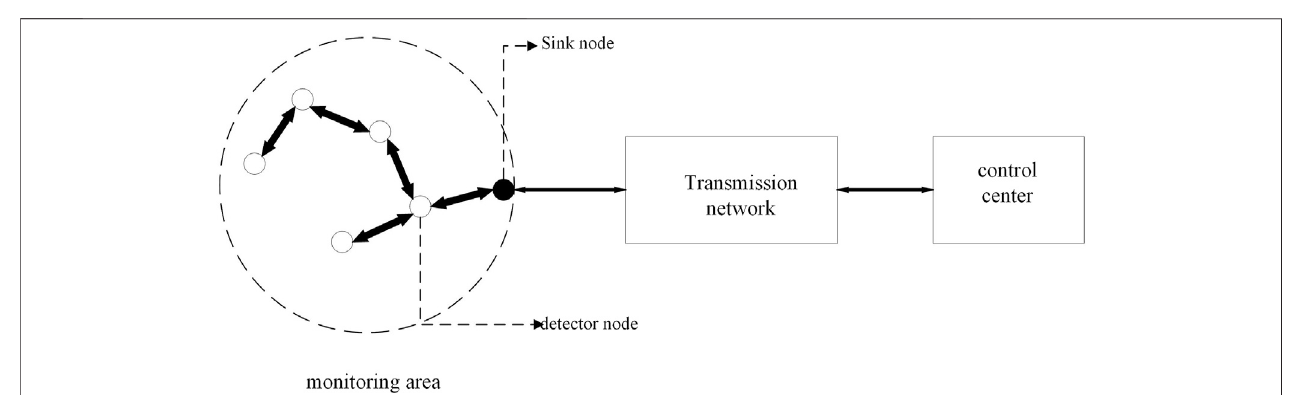
FIGURE 2 | Components of the distributed radiation detector